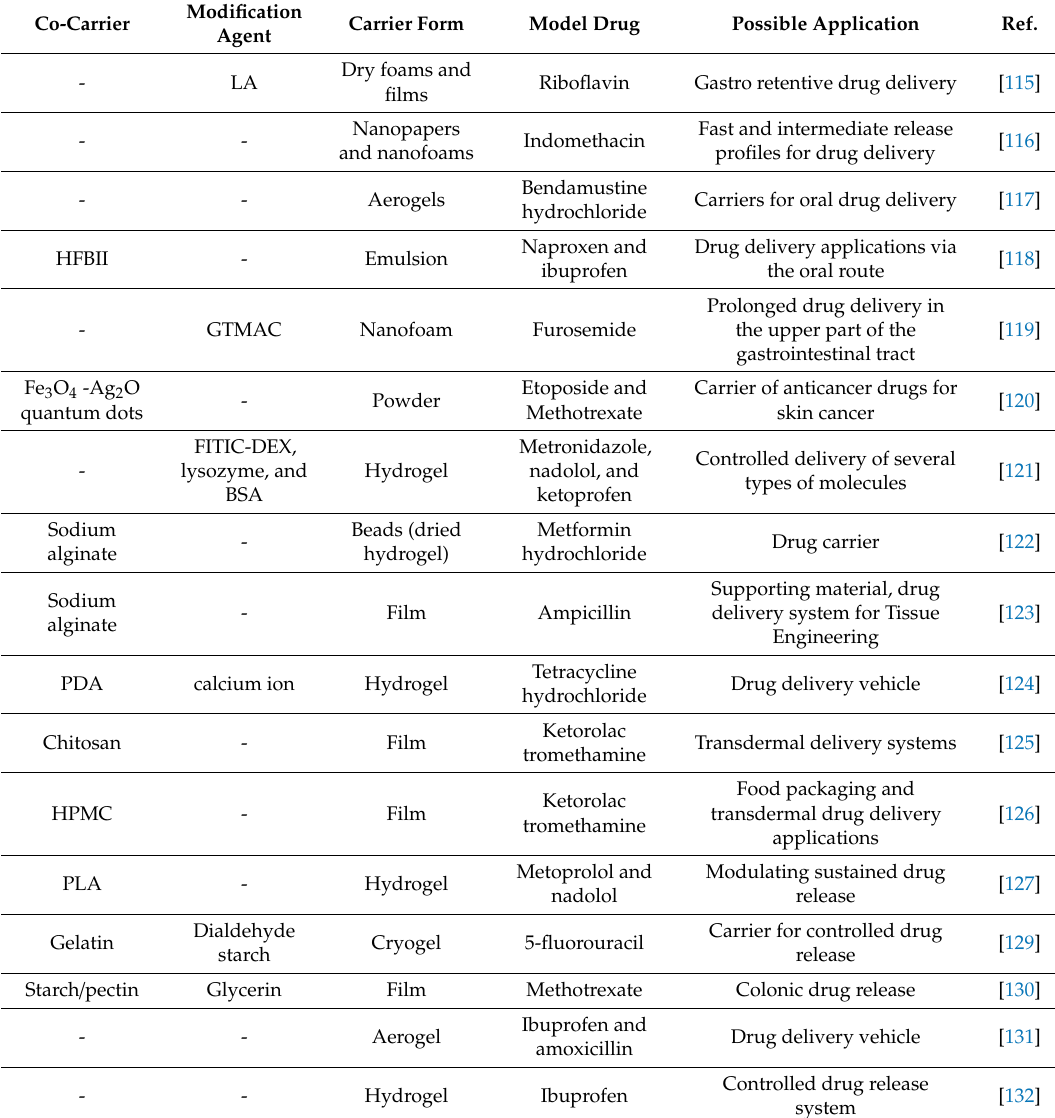
Table 2. Diverse CNF-based delivery systems with specific modification agents, carrier forms, model drugs, and potential